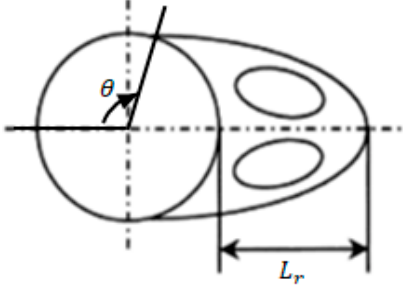
Figure 18. Definition of recirculation length and separation angle